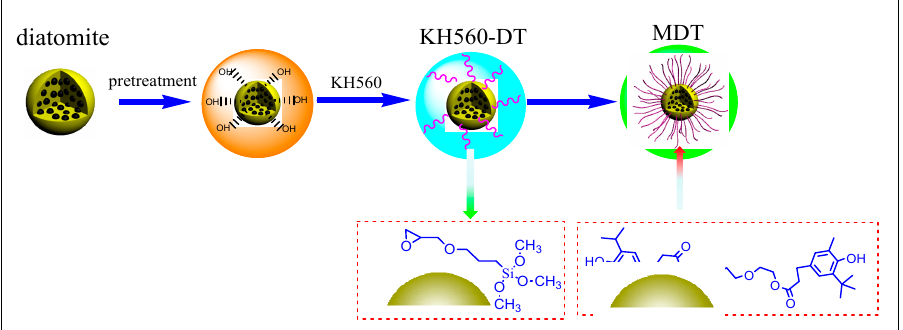
Figure 1. Scheme of modification process of MDT.